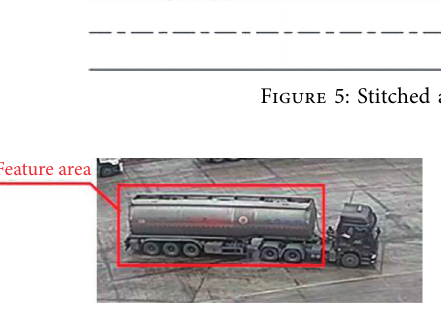
Figure 6: Tank containers and detection feature